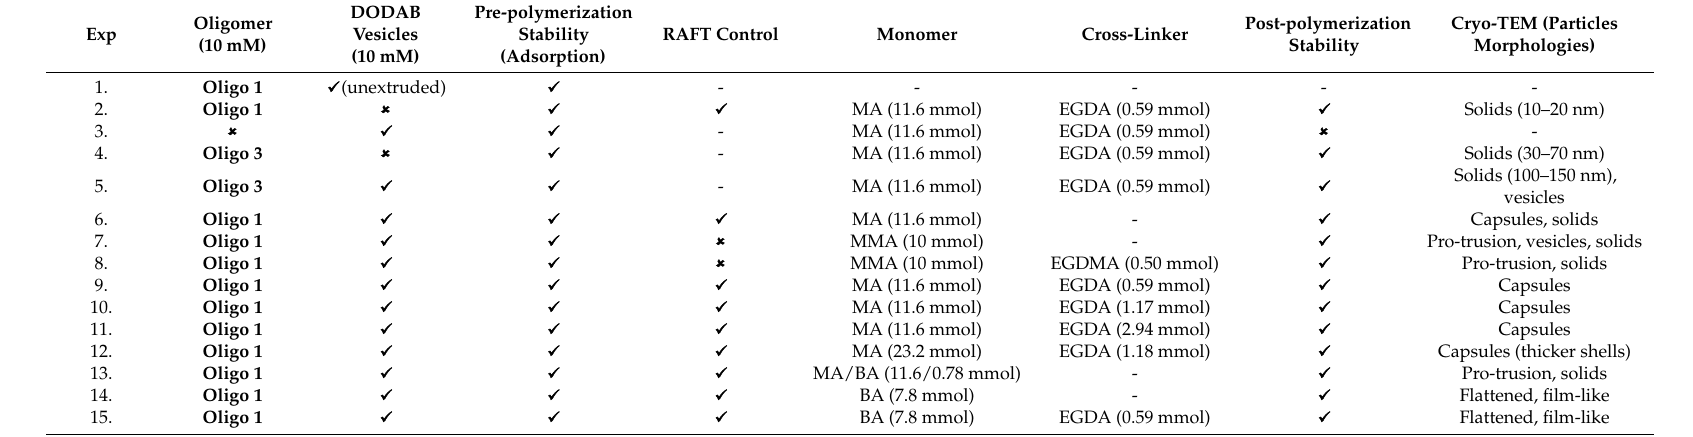
Table 3. Vesicles polymerization with Oligo 1 [RAFT1481 (BA 6 - co -AA 9 ).